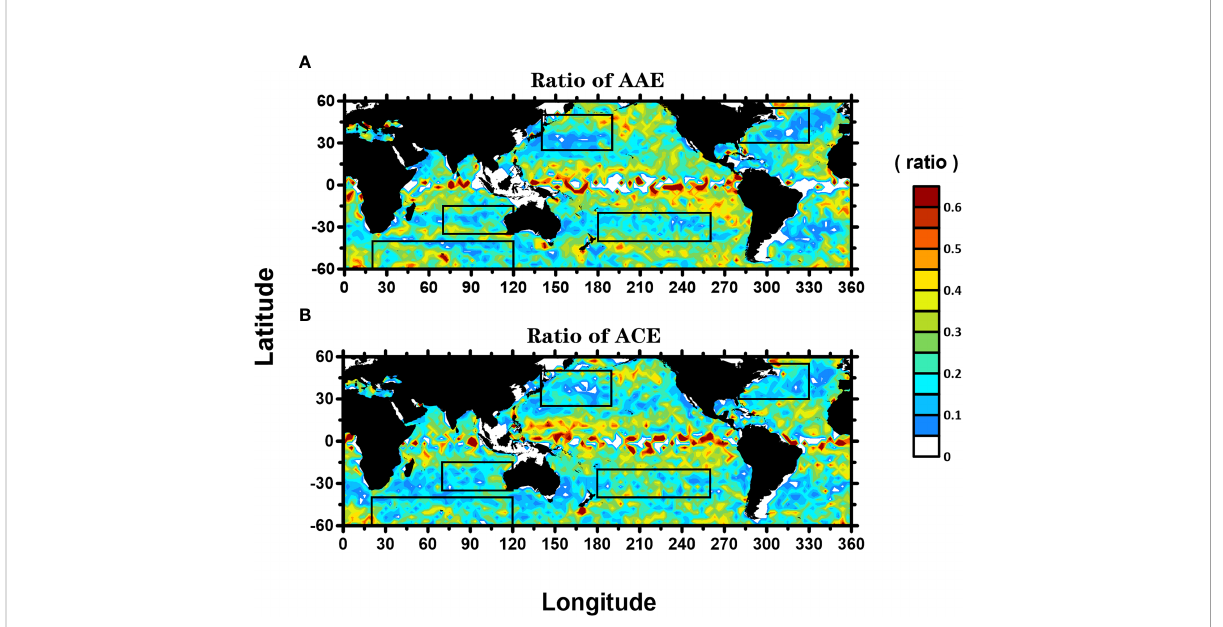
FIGURE 4 Proportions of abnormal eddies in global 3° × 3° grid. The ratio of the number of AAE (A) and ACE (B) to the number of TAE and TCE detected in each grid over the 15-yr period of 2003 – 2017. The black box indicates fi ve areas (NA, North Atlantic Ocean 30° – 55° N, 280° – 330° E;